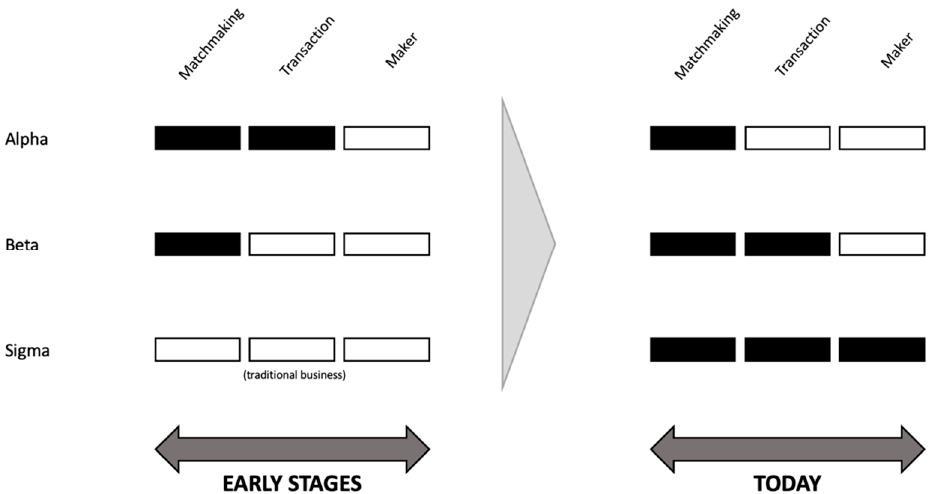
Figure 3. Evolution of value proposition and functions in the three case studies.